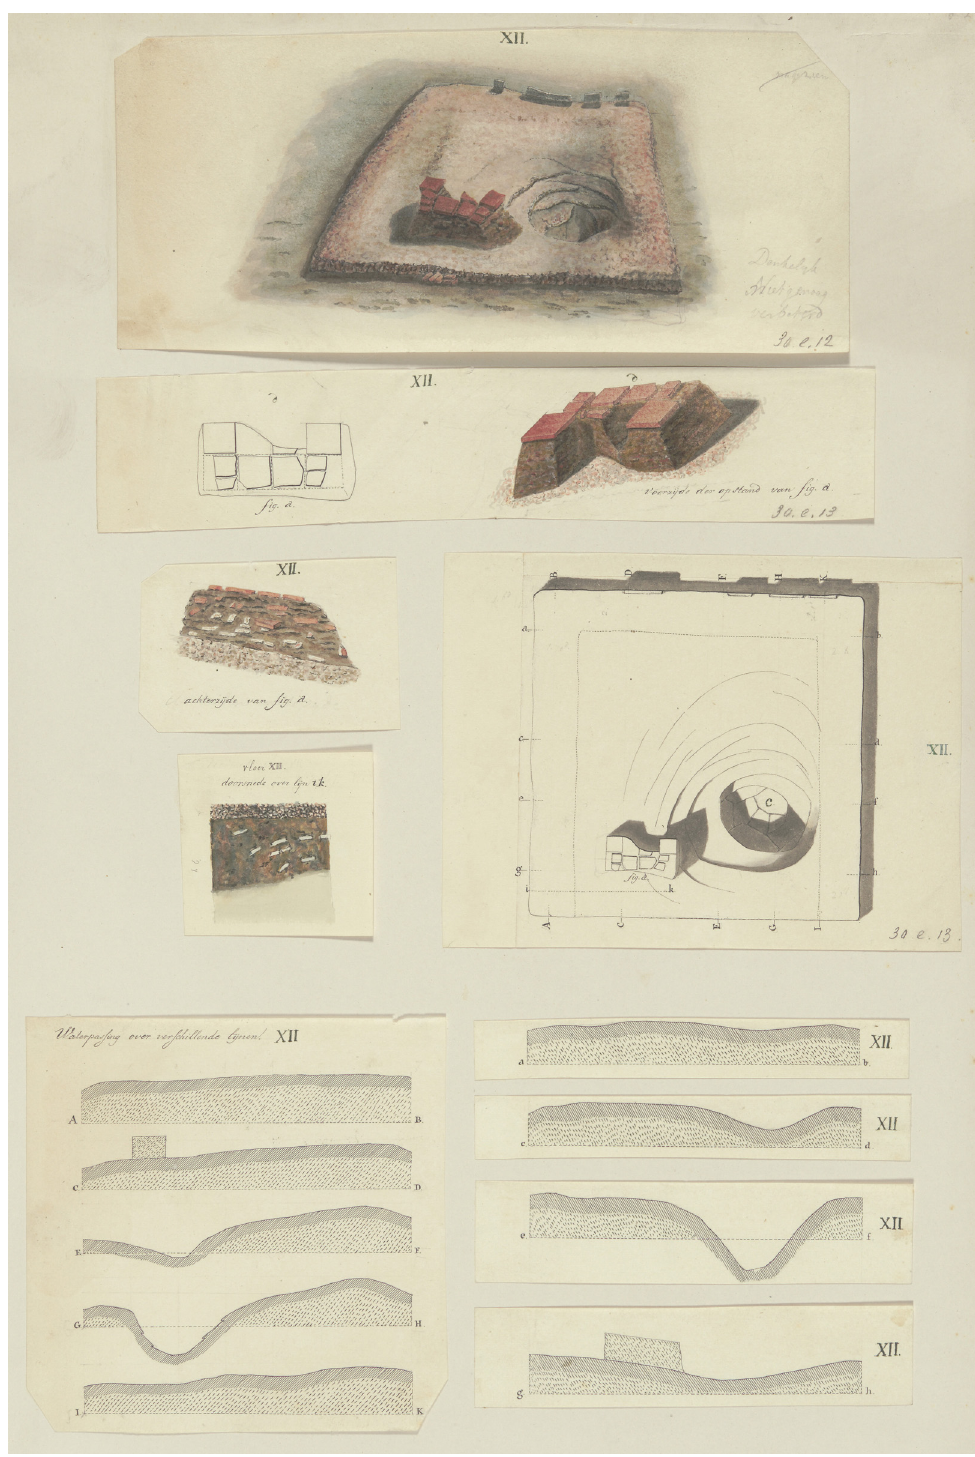
Figure 6: Detailed documentation of a fi nd context consisting of both watercolours and line drawings, in perspective, plan, and section. Courtesy of the National Museum of Antiquities, Leiden [ RA 30 e.12 ]